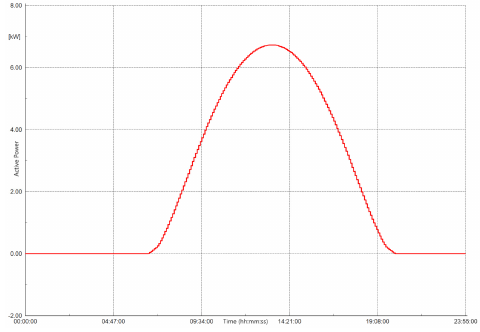
Figure 1. Active power of Aleo PV